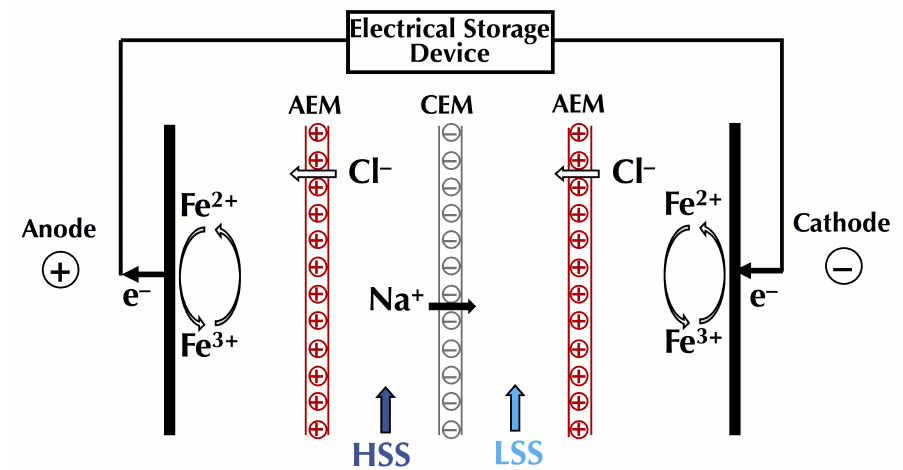
Figure 23. Principle of reverse ED. CEM: cation-exchange membrane; AEM: anion-exchange membrane; HSS: high-salinity stream; LSS: low-salinity